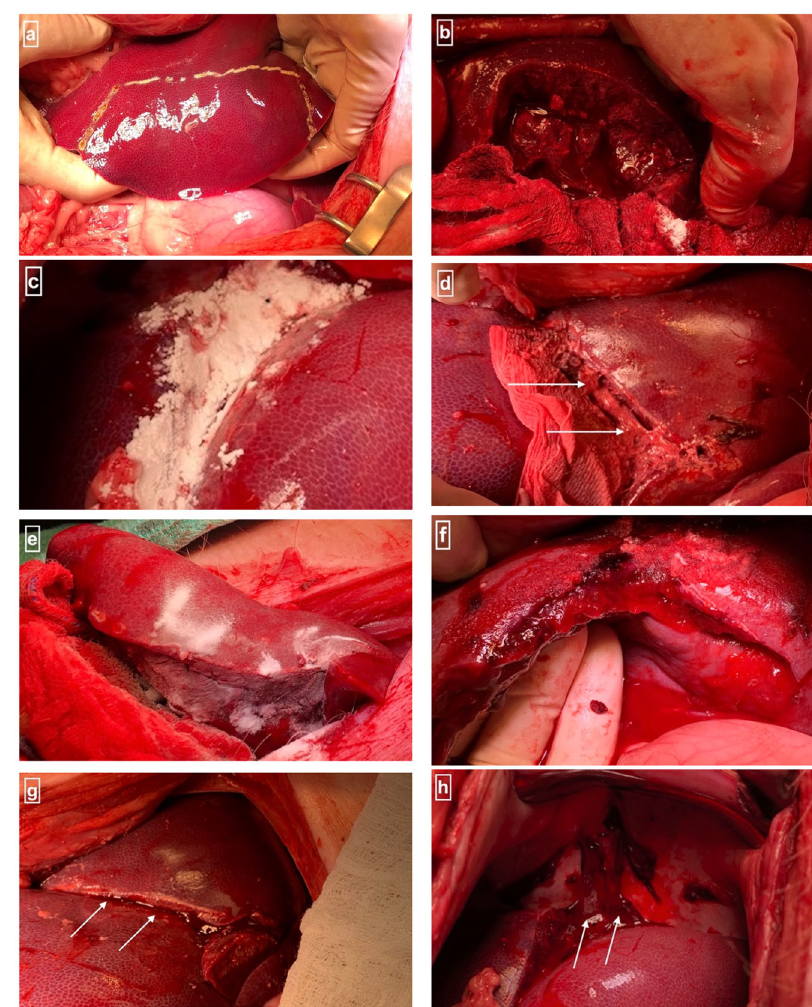
Fig. 1 In vivo porcine liver injury and intervention application. This shows the representative images of the porcine liver injury in vivo surgery: a the part of the liver is marked for avulsion; b the injured section of the liver is shown from which the liver tissue was avulsed; c the sprinkled Ta-MBG powder; d the bleeding site with Ta- MBG at 5 min time point; e sprinkled Arista TM powder; f the bleeding site with Arista TM at 5 min time point; g the bleeding site with Ta-MBG at 10 min time point; folding of the liver is evident here (arrows); h blood clot (arrows) at the injured site with